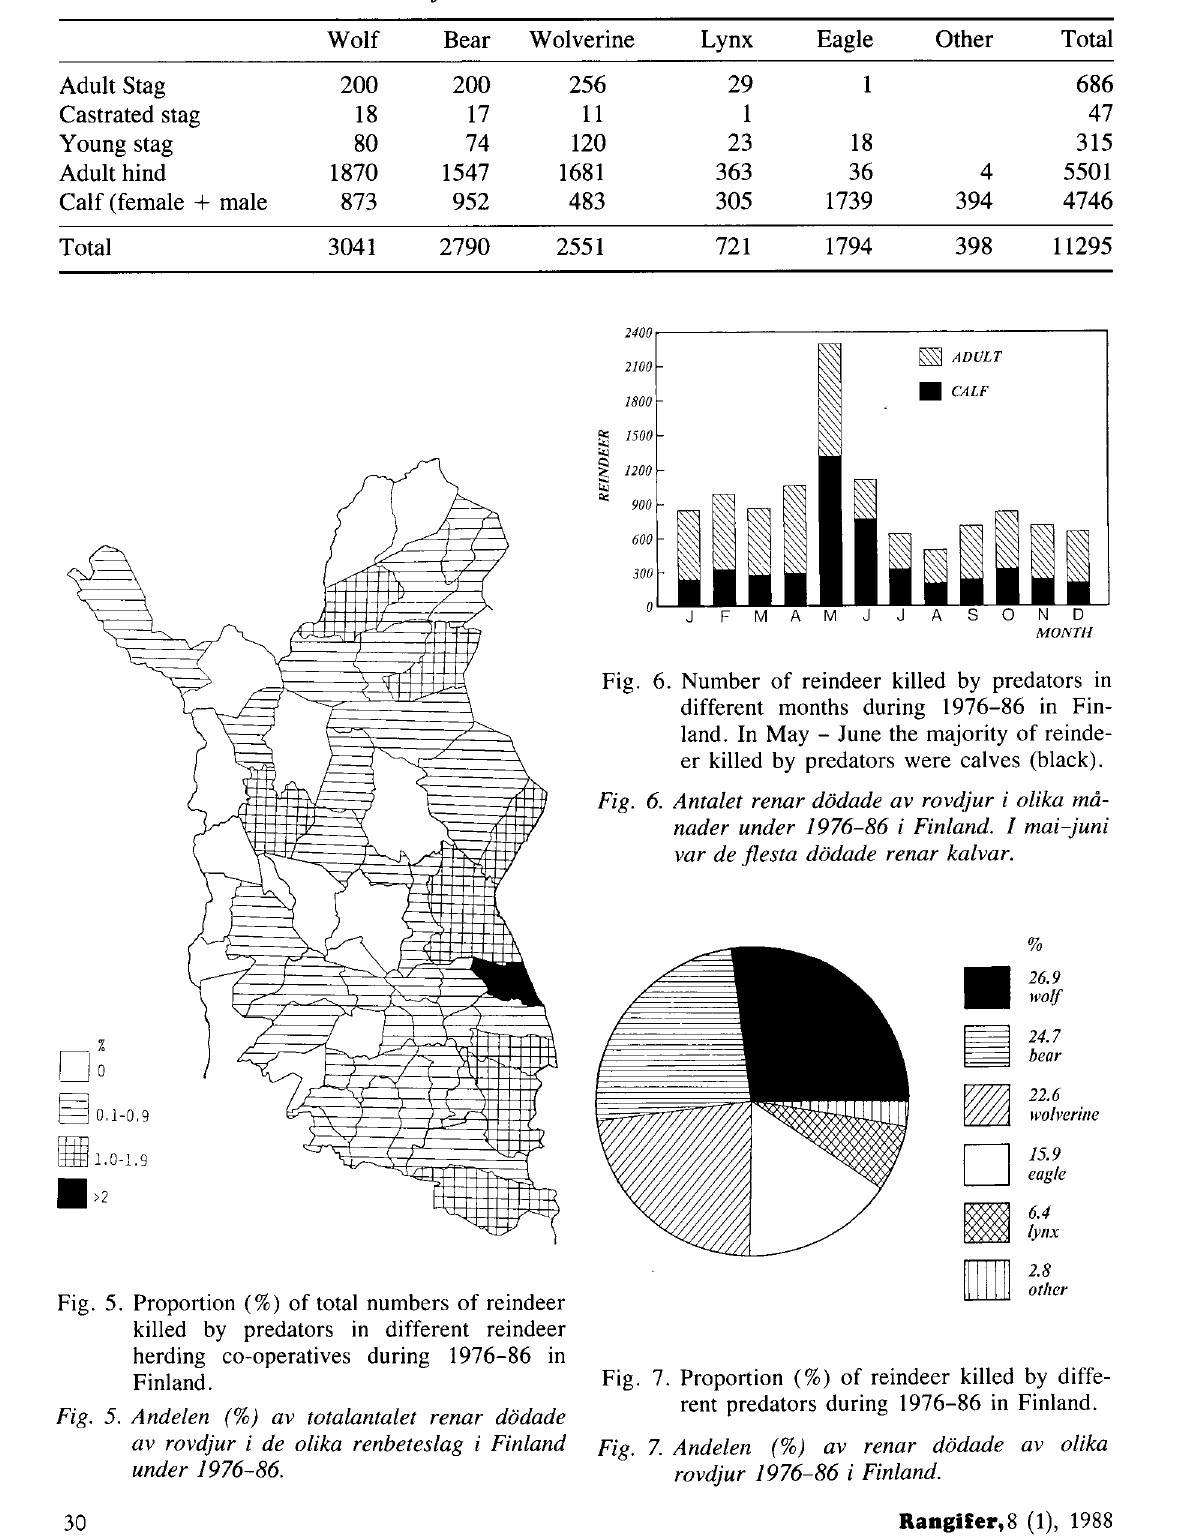
Fig. 7. Proportion (%) of reindeer killed by diffe rent predators during 1976-86 in Finland. Fig. 7. Andelen (%) av renar dödade av olika rovdjur 1976-86 i Finland. Rangif er, 8 (1),